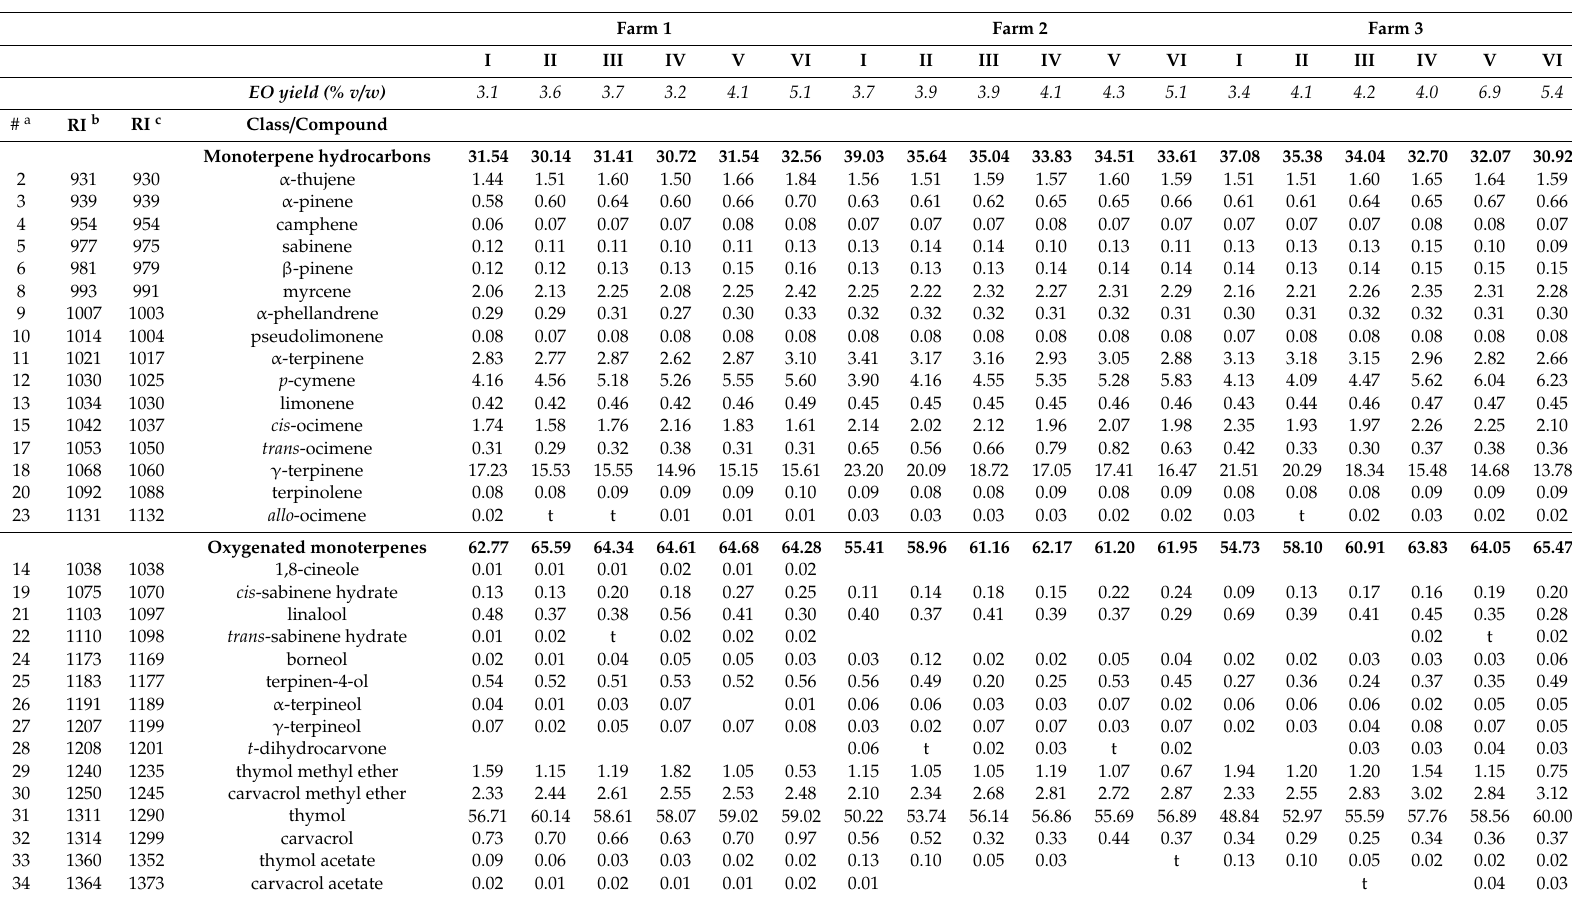
Table 3. Origanum heracleoticum . 2015. EO yield and composition (relative peak area percent) in plants cultivated in 3 Sicilian farms (1 to 3) in 6 harvest times (I to